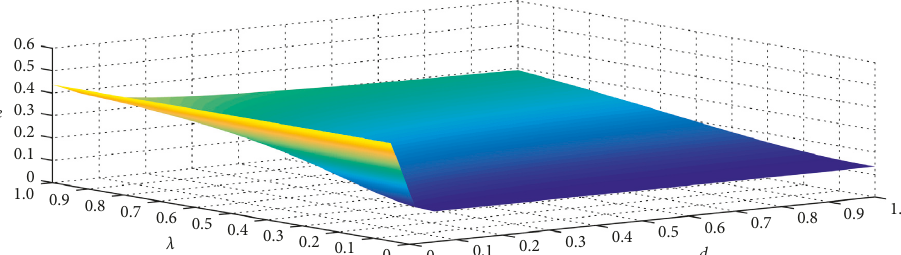
Figure 3: Developer’s optimal productive efforts level e .